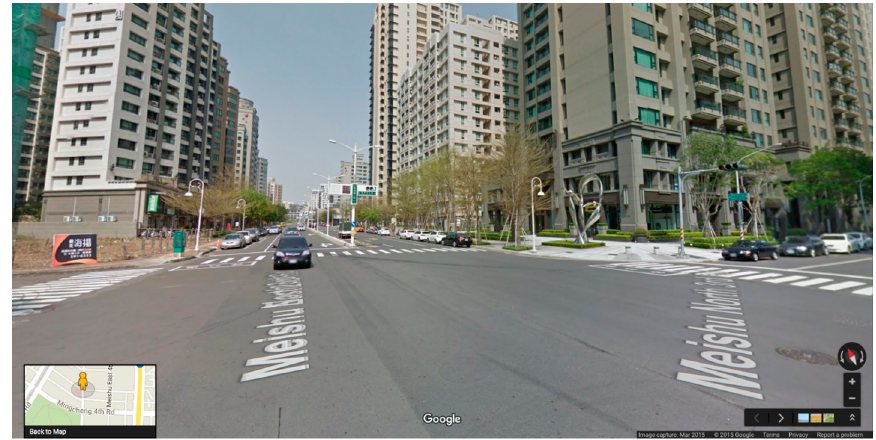
Figure 2. Example of a neighborhood in Kaohsiung City where the walkable environment is relatively good. Source: Google Street View.